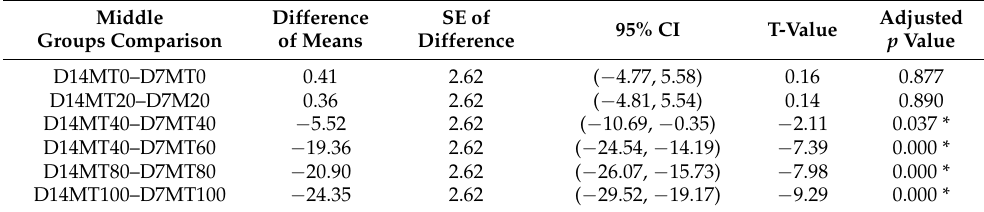
Table 5. Fisher test for 14 mm vs. 7 mm in the middle area. * p < 0.05. Middle Groups